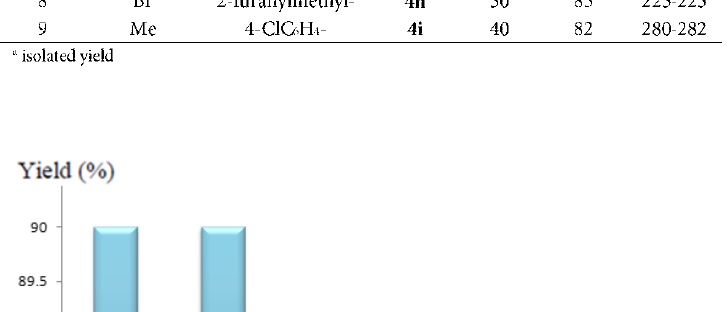
H nanocomposite as a catalyst for the model 3